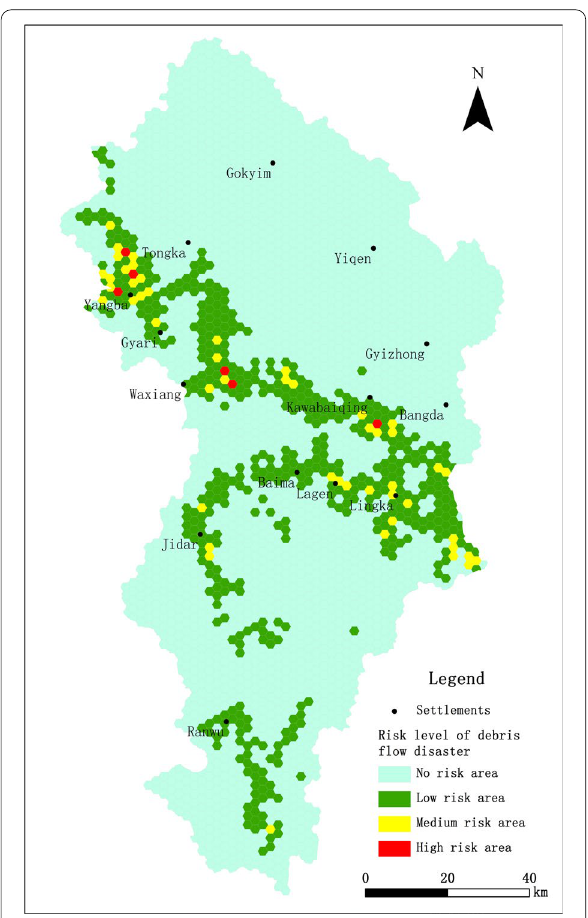
Fig. 16 Classification of debris-flow risk levels in Basu